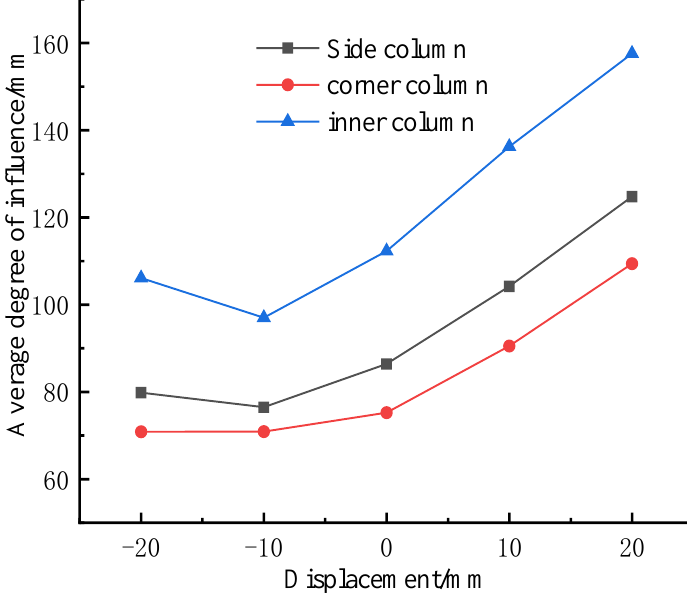
Figure 7. Initial displacement.